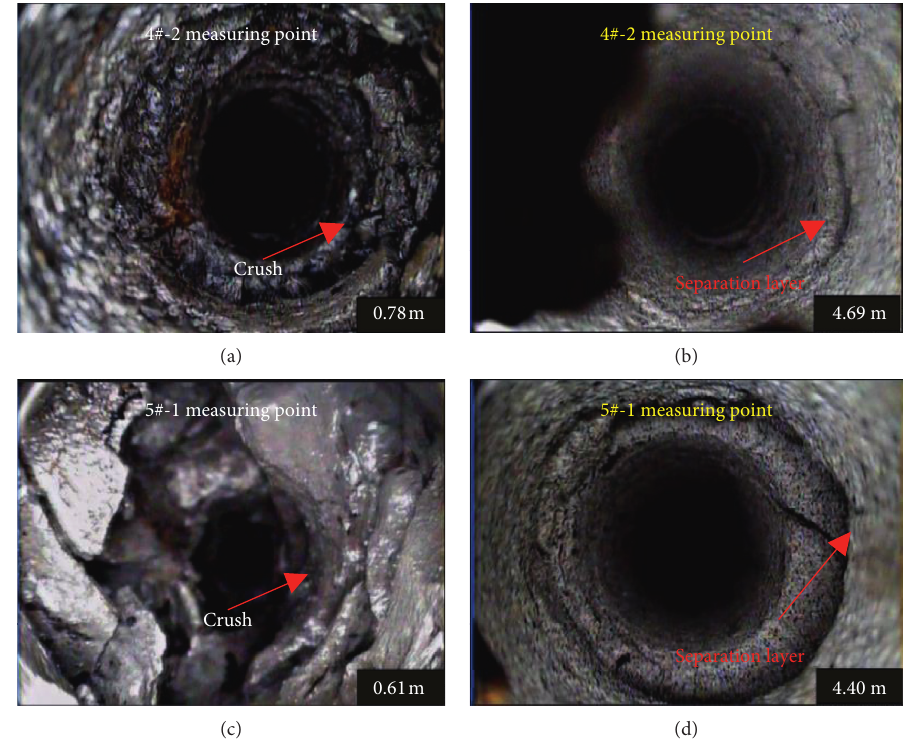
Figure 10: Images of different depths of borehole TV at two measuring points.